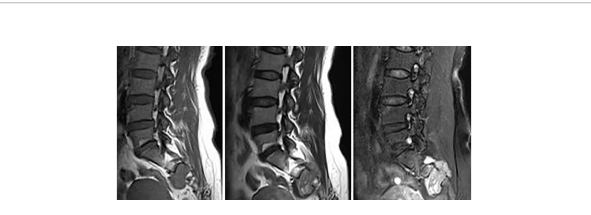
FIGURE 3 | Primary spinal epithelioid hemangioendothelioma (EHE) in a 42- year-old woman. A sagittal image of the lumbar spine reveals a mass in the sacral 2 – 4 vertebrae with a paravertebral soft tissue mass. MRI showed an inhomogeneous low signal on T 1 -weighted image (T 1 WI) and a high signal on T 2 WI with punctate low-signal foci. Contrast-enhanced MRI demonstrated intensive inhomogeneous enhancement of the lesions with punctate low- signal